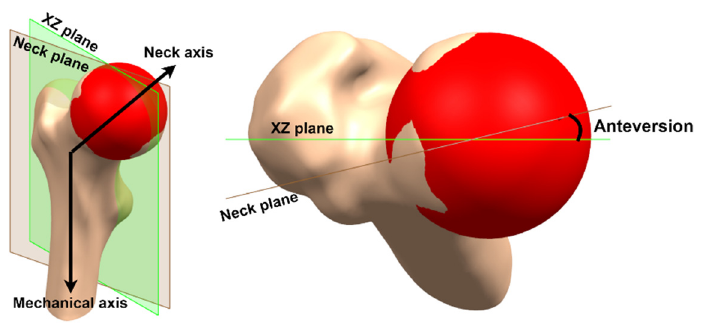
Figure 4. Anteversion. Figure 4.